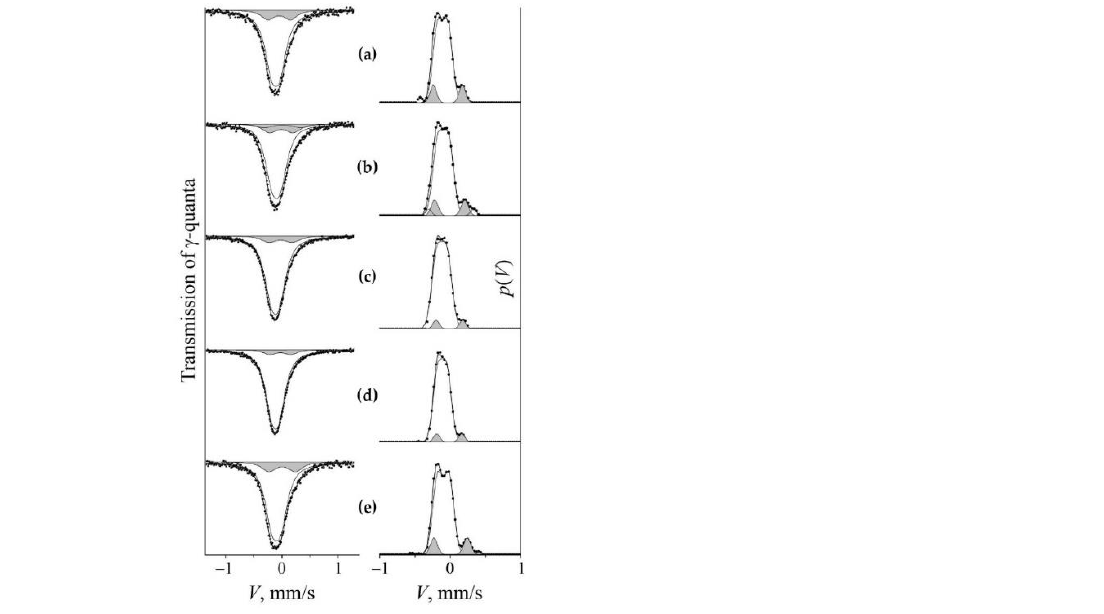
Figure 5. Mössbauer spectra and p ( V ) distributions for quenched FeMn 22 Cr 18 N 0.83 steel with a change in the deformation temperature of the HPT of n = 3 rev. Treatment: ( a ) — quenching; ( b ) — HPT of n = 3 rev. at 298 K; ( c ) — HPT of n = 3 rev. at 373 K; ( d ) HPT of n = 3 rev. at 573 K; ( e ) — HPT of n = 3 rev. at 298 K, followed by annealing at 573 K, for 30 min. The component of the “ nitrogenous ” doublet S D 1 is highlighted by darkening.